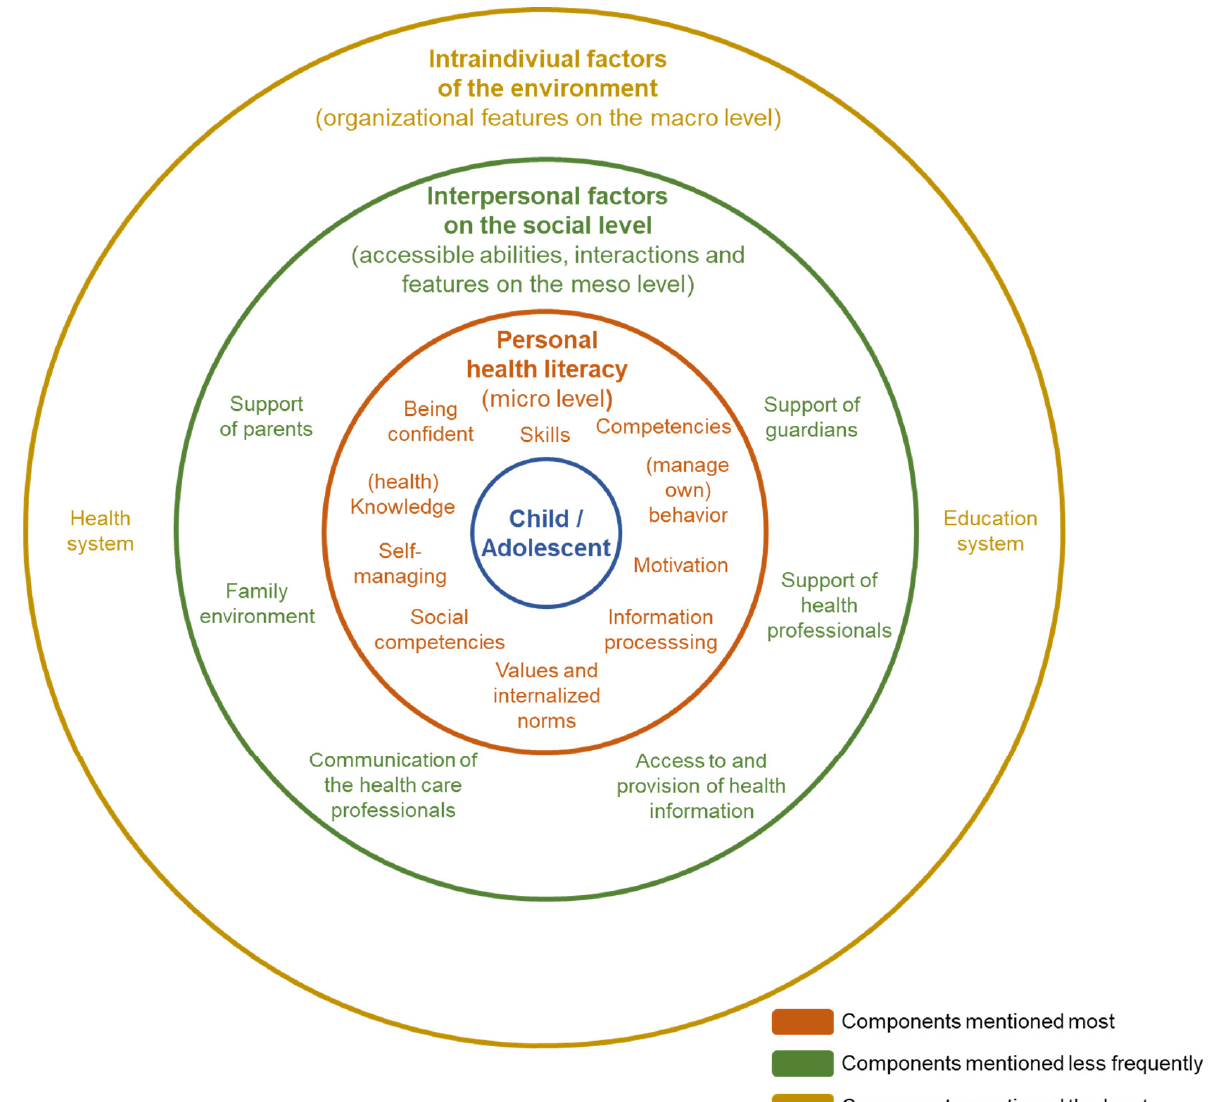
Figure 3. Health literacy defined for children and adolescents—frequency of mentions in the interviews referring to micro, meso, and macro levels based on Bronfenbrenners socio-ecological model [15].